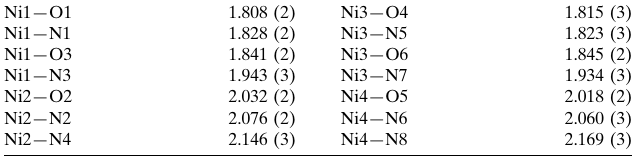
Selected bond lengths (A˚ ).